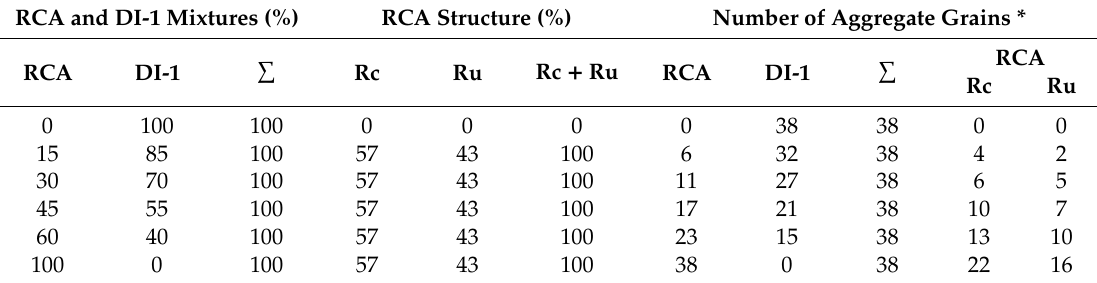
Figure 3. Test samples for PSV with projected (38 ± 2) aggregate particles: ( a ) Dolerite; ( b ) mixtures Table 1. Preparation of PSV test samples according to the RCA and DI-1 mixtures design and RCA structure.